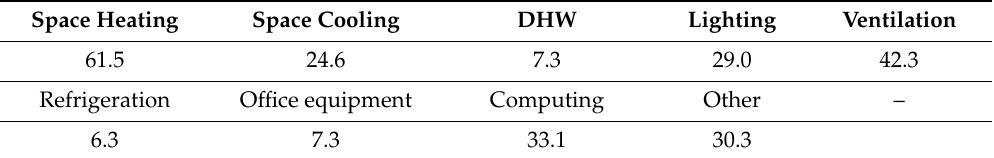
Table 16. Major energy (electricity, natural gas, fuel oil and district heating) consumption intensities by